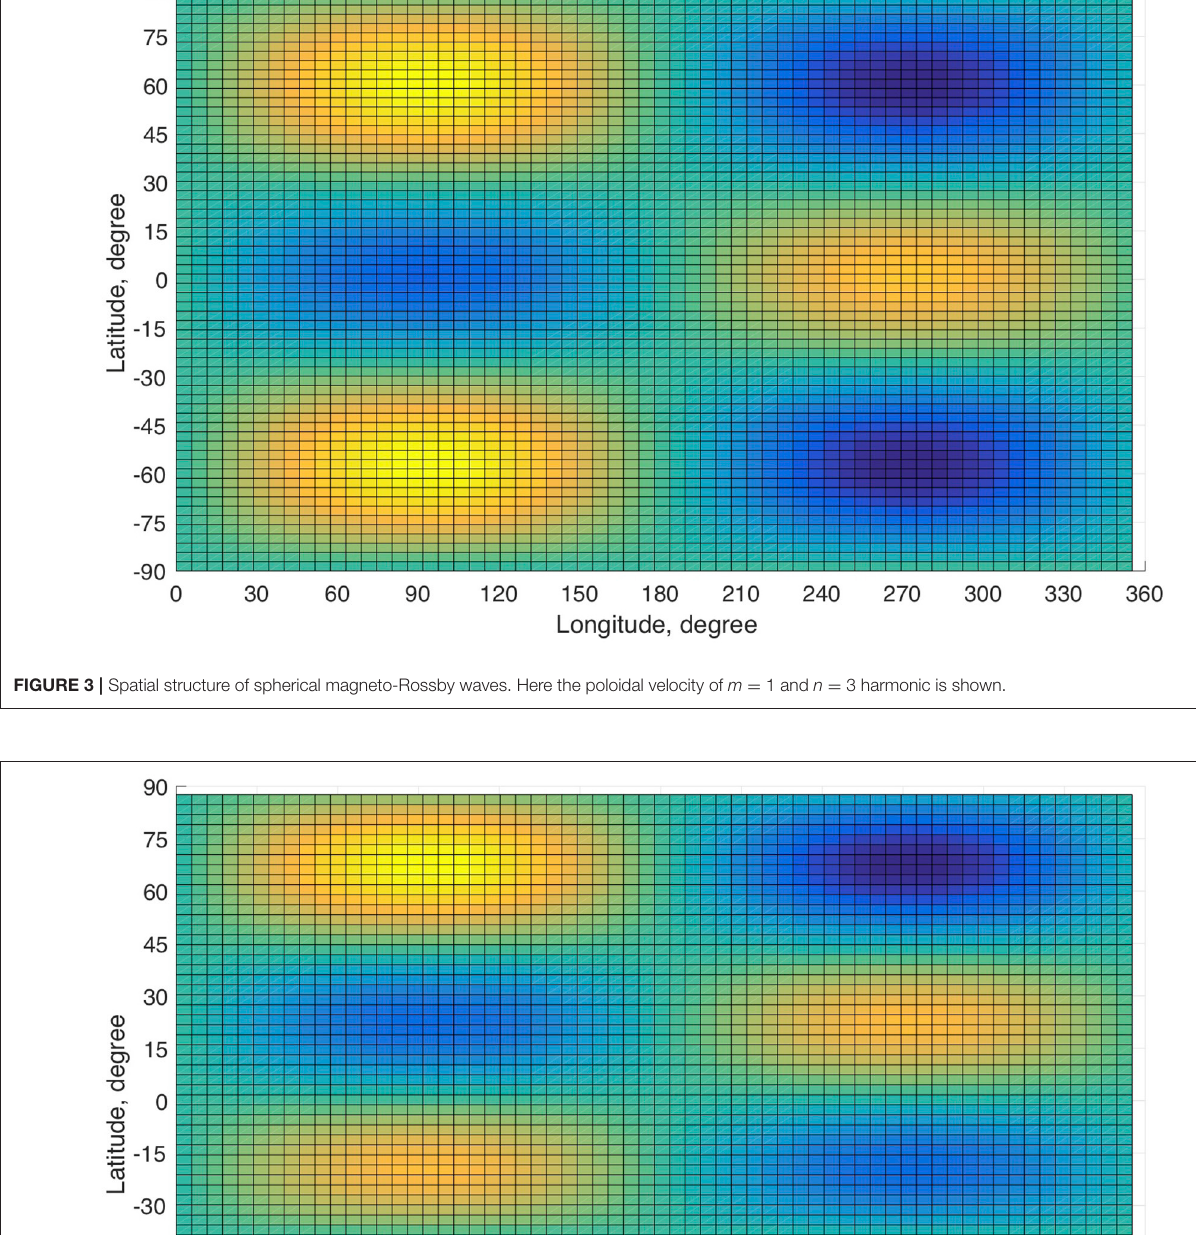
FIGURE 4 | Spatial structure of spherical magneto-Rossby waves. Here the poloidal velocity of m